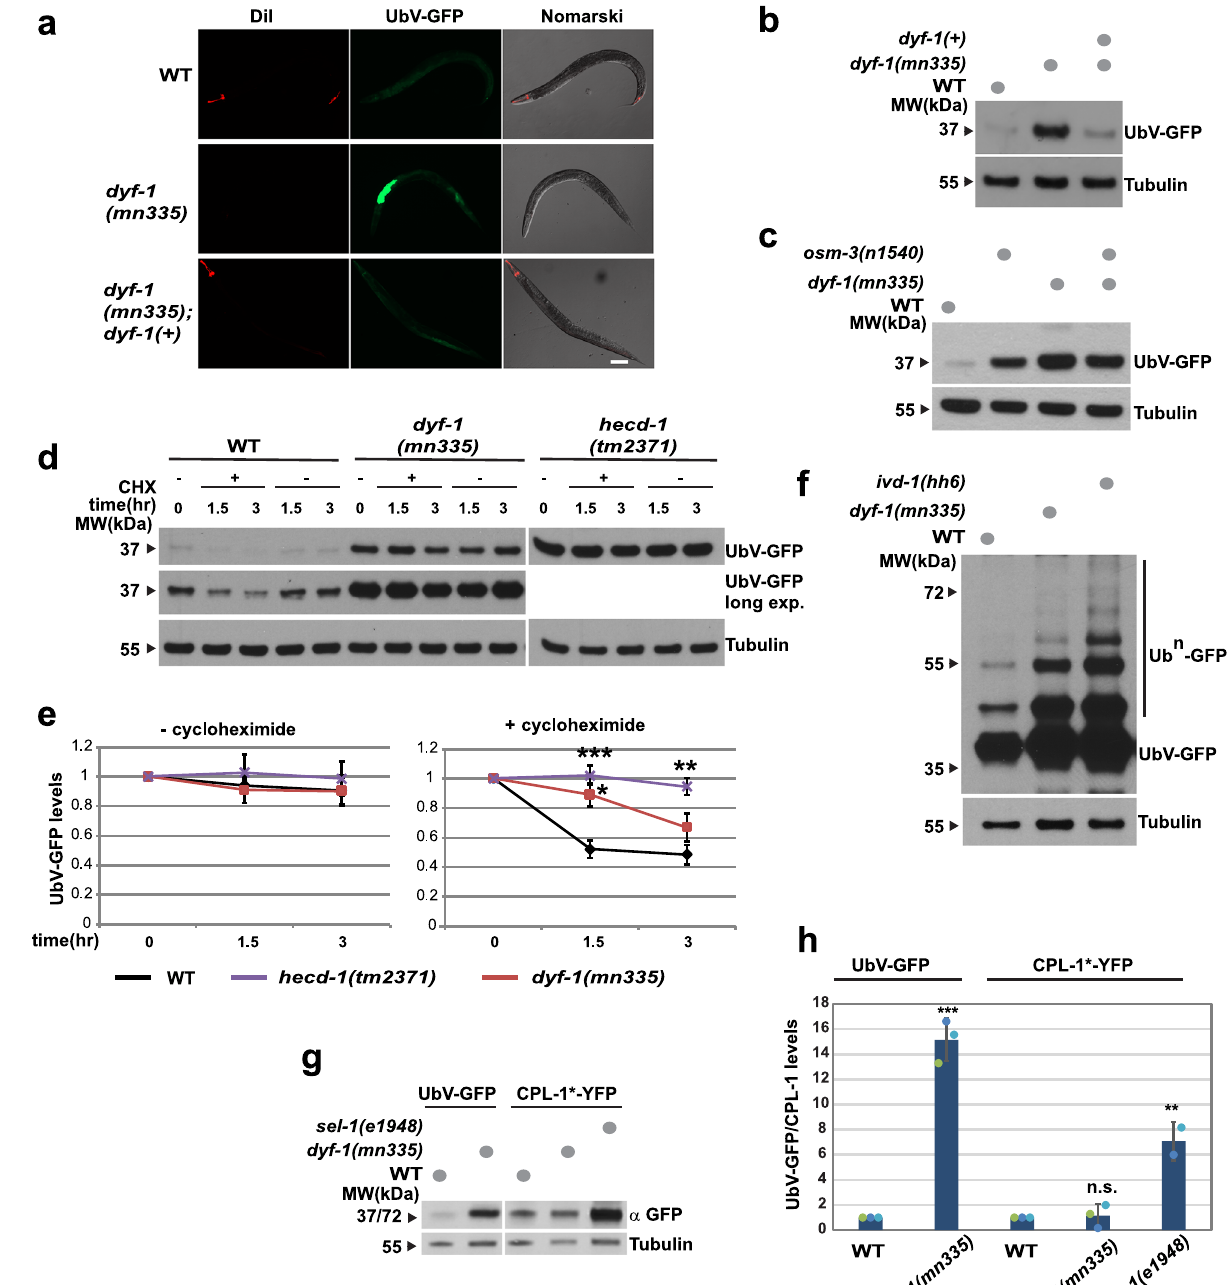
Fig. 1 | Defective sensory cilia mutants show reduced UPS-dependent protein degradation. a Fluorescence and Nomarski images of worms expressing the UFD substrate in WT, dyf-1(mn335); dyf-1(+) and the direct sibling lacking the dyf-1 array (dyf-1(mn335)) . DiI: ciliated amphid and phasmid neurons. Scale bar: 100 μ m. b Protein lysates of worms displayed in ( a ) were analysed by Western blotting against GFP and tubulin. Dots: presence of indicated mutation. a , b n =3 biologi- cally independent experiments. c Protein lysates of indicated WT and mutant worms. n =5 biologically independent experiments. d Protein lysates of wild-type, dyf-1(mn335) or hecd-1(tm2371) worms after ethanol ( − ) or 0.5mg/mL cyclohex- imideinethanoltreatmentfortheindicatedtimepoints.Wormswereanalysedasin ( b ). long exp.=long exposure of the blot. e Quanti fi cation of 4 biologically inde- pendentexperimentsfrom( d ),average±standarddeviation,one-wayANOVAwith Bonferroni ’ s multiple comparisons test, hecd-1(tm2371) 1.5h p =0.0004, hecd- 1(tm2371) 3h p =0.0012, dyf-1(mn335) 1.5h p =0.0166, dyf-1(mn335) 3h p >0.9999, ratiosofmutantsversusratiosofwild-typewithcycloheximide. f WTandindicated